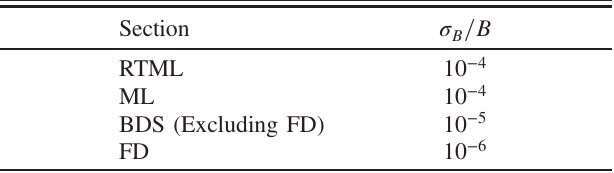
TABLE IV. Quadrupole ripple tolerances σ B =B for specific sections. FD is the final